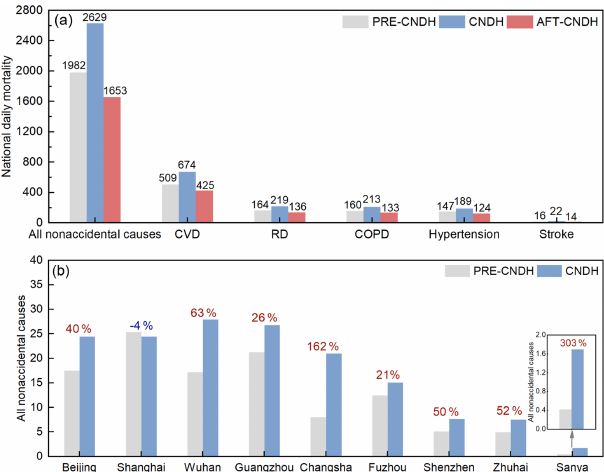
Figure 6. (a) National daily mortality from all non-accidental causes, CVD, RD, COPD, hypertension, and stroke attributed to O 3 in PRE-CNDH, CNDH, and AFT-CNDH and (b) daily mortal- ity from all non-accidental causes due to O 3 in the nine key cities. Red/blue values above the bars are the increase/decrease rates of daily mortality from PRE-CNDH to CNDH. CVD: cardiovascular disease; RD: respiratory disease; COPD: chronic obstructive pul- monary